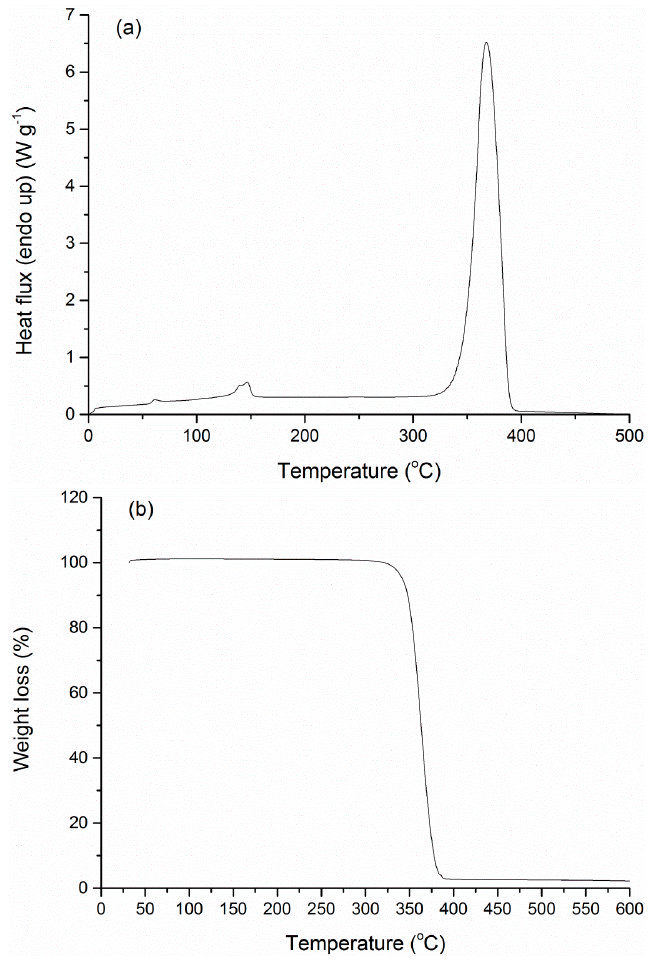
Figure 7. ( a ) Differential scanning calorimetry (DSC) and ( b ) thermogravimetric analysis (TGA) curve of the PLA grade used as encapsulation carrier.